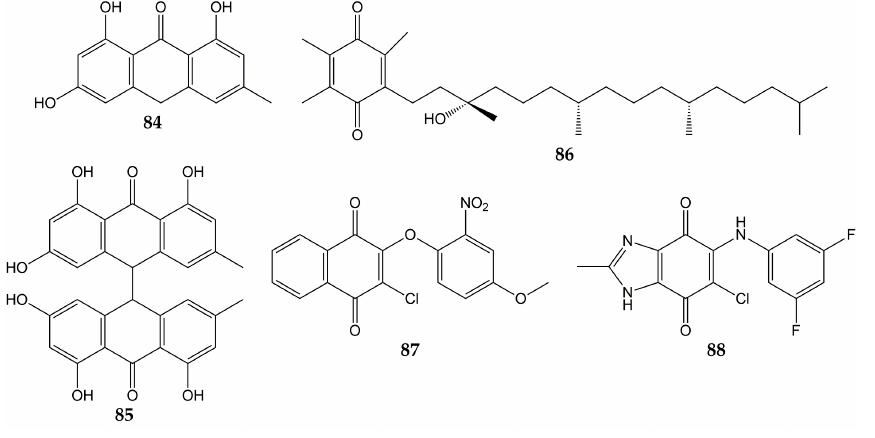
Figure 9. Chemical structures of quinones 84 – 88 .